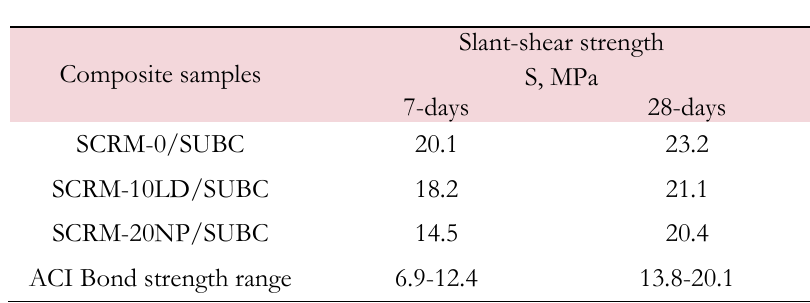
Table 3: Slant shear strength results.